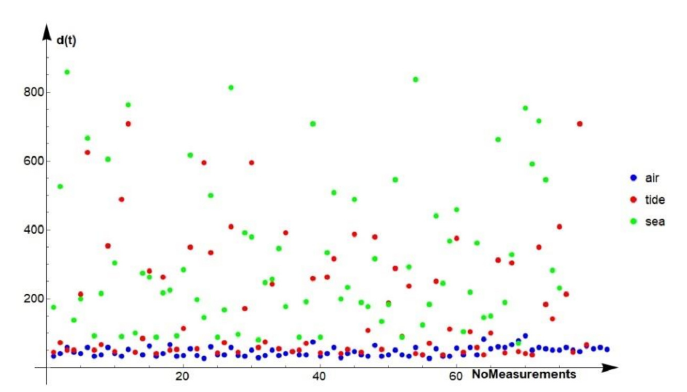
Figure 6. Display of raw data for the NiTi-2 alloy.